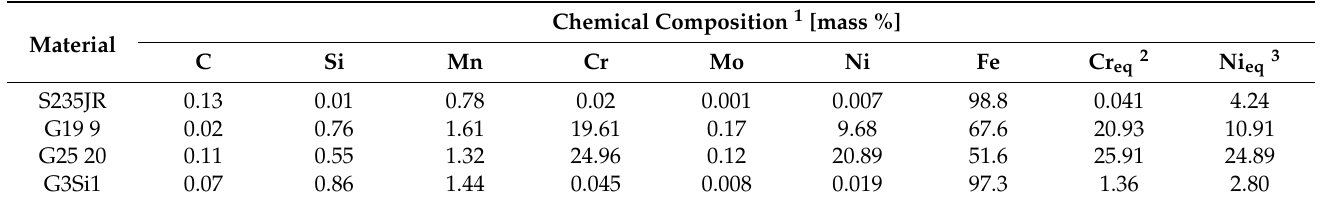
Table 1. Chemical composition of the used materials in mass % measured by OES